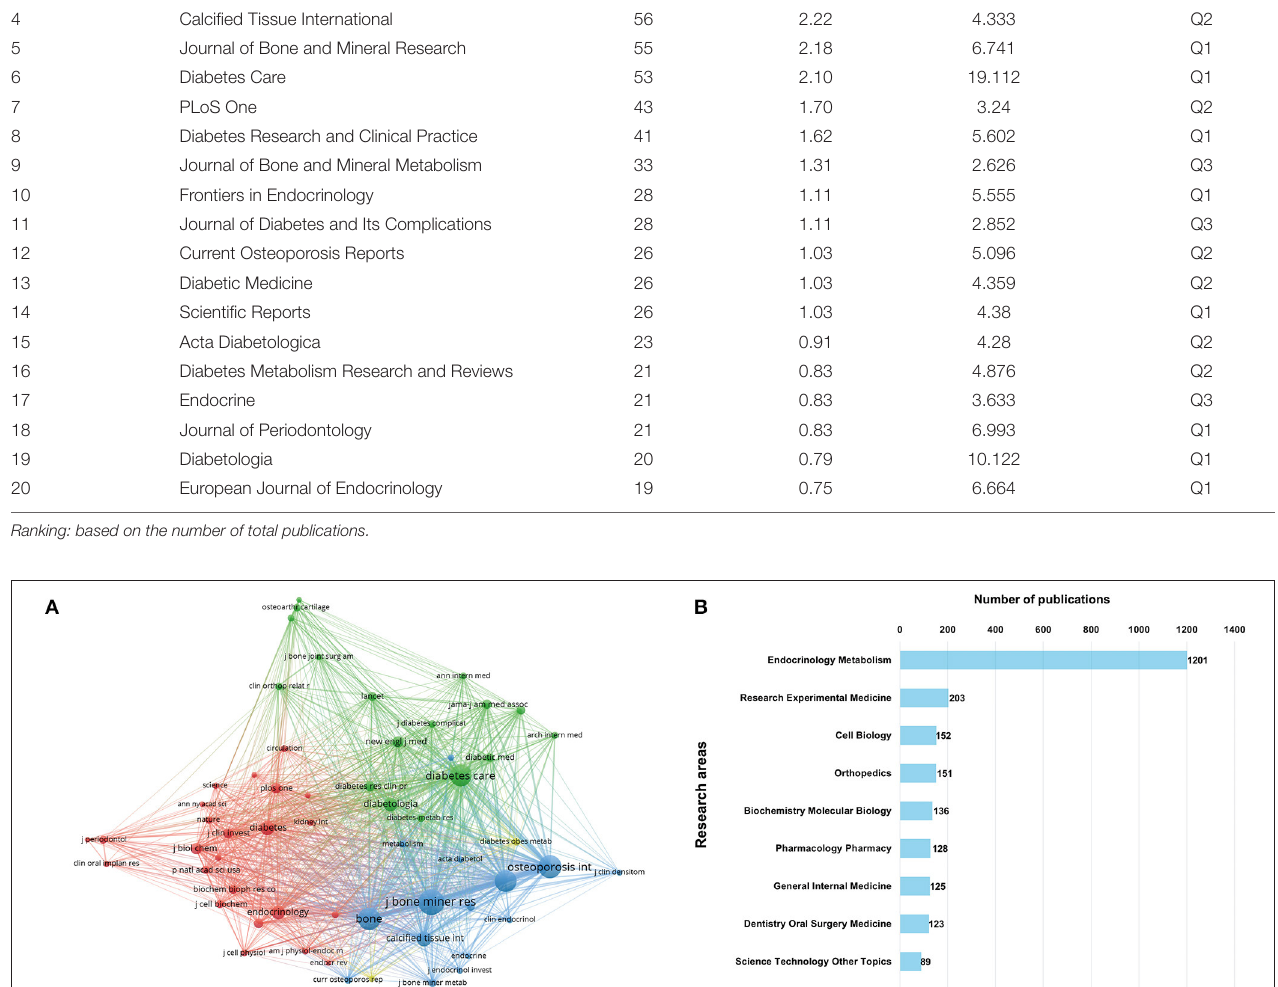
analysis, the main research directions, hotspots, and evolution process in the field can be uncovered (54,